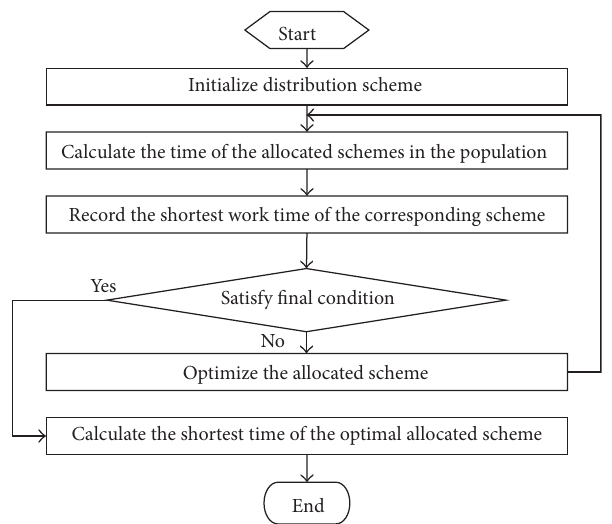
Figure 4: Flowchart of acquiring the optimal allocated scheme and the shortest work